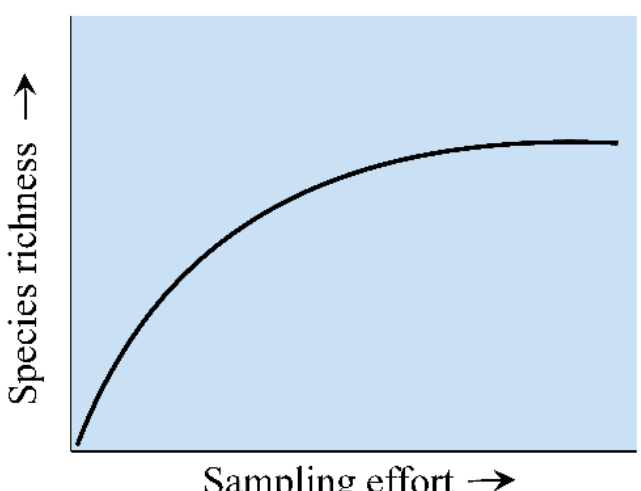
Figure 1. A conceptual diagram of species accumulation curves showing the cumulative number of species (species richness) recorded in a particular area as a function of the cumulative effort expended searching for them (sampling effort).